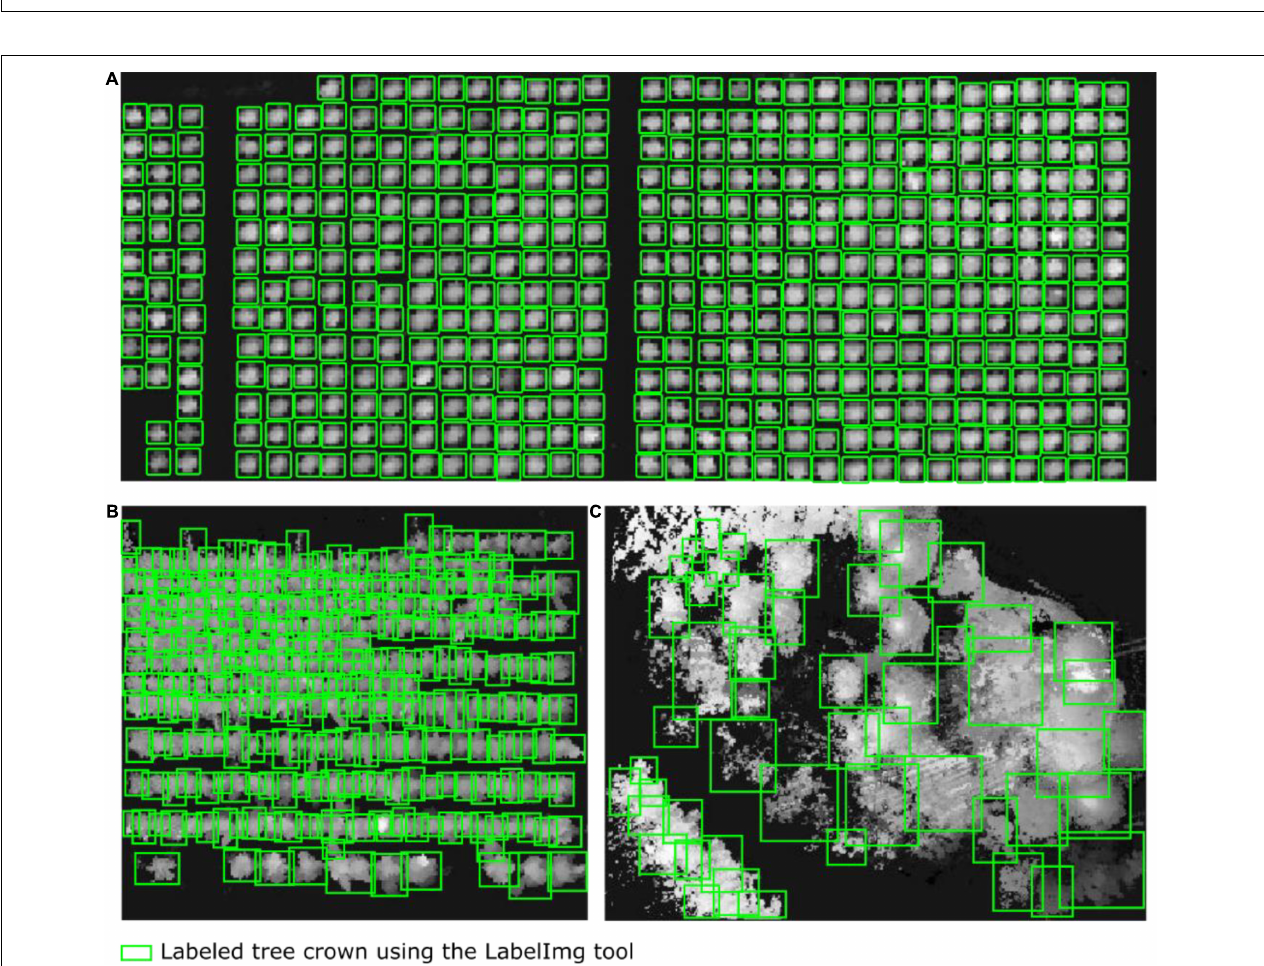
FIGURE 2 | Diagrams showing some of the training samples manually labeled using the LabelImg tool. The tree crowns in the heightmaps were generated from the airborne LiDAR data of (A) the tree nursery, (B) the forest landscape area, and (C) the mixed tree habitat.